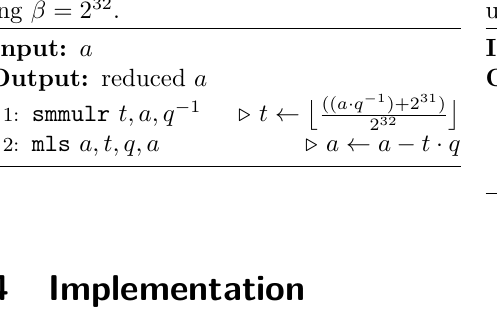
Algorithm 8 32-bit Montgomery